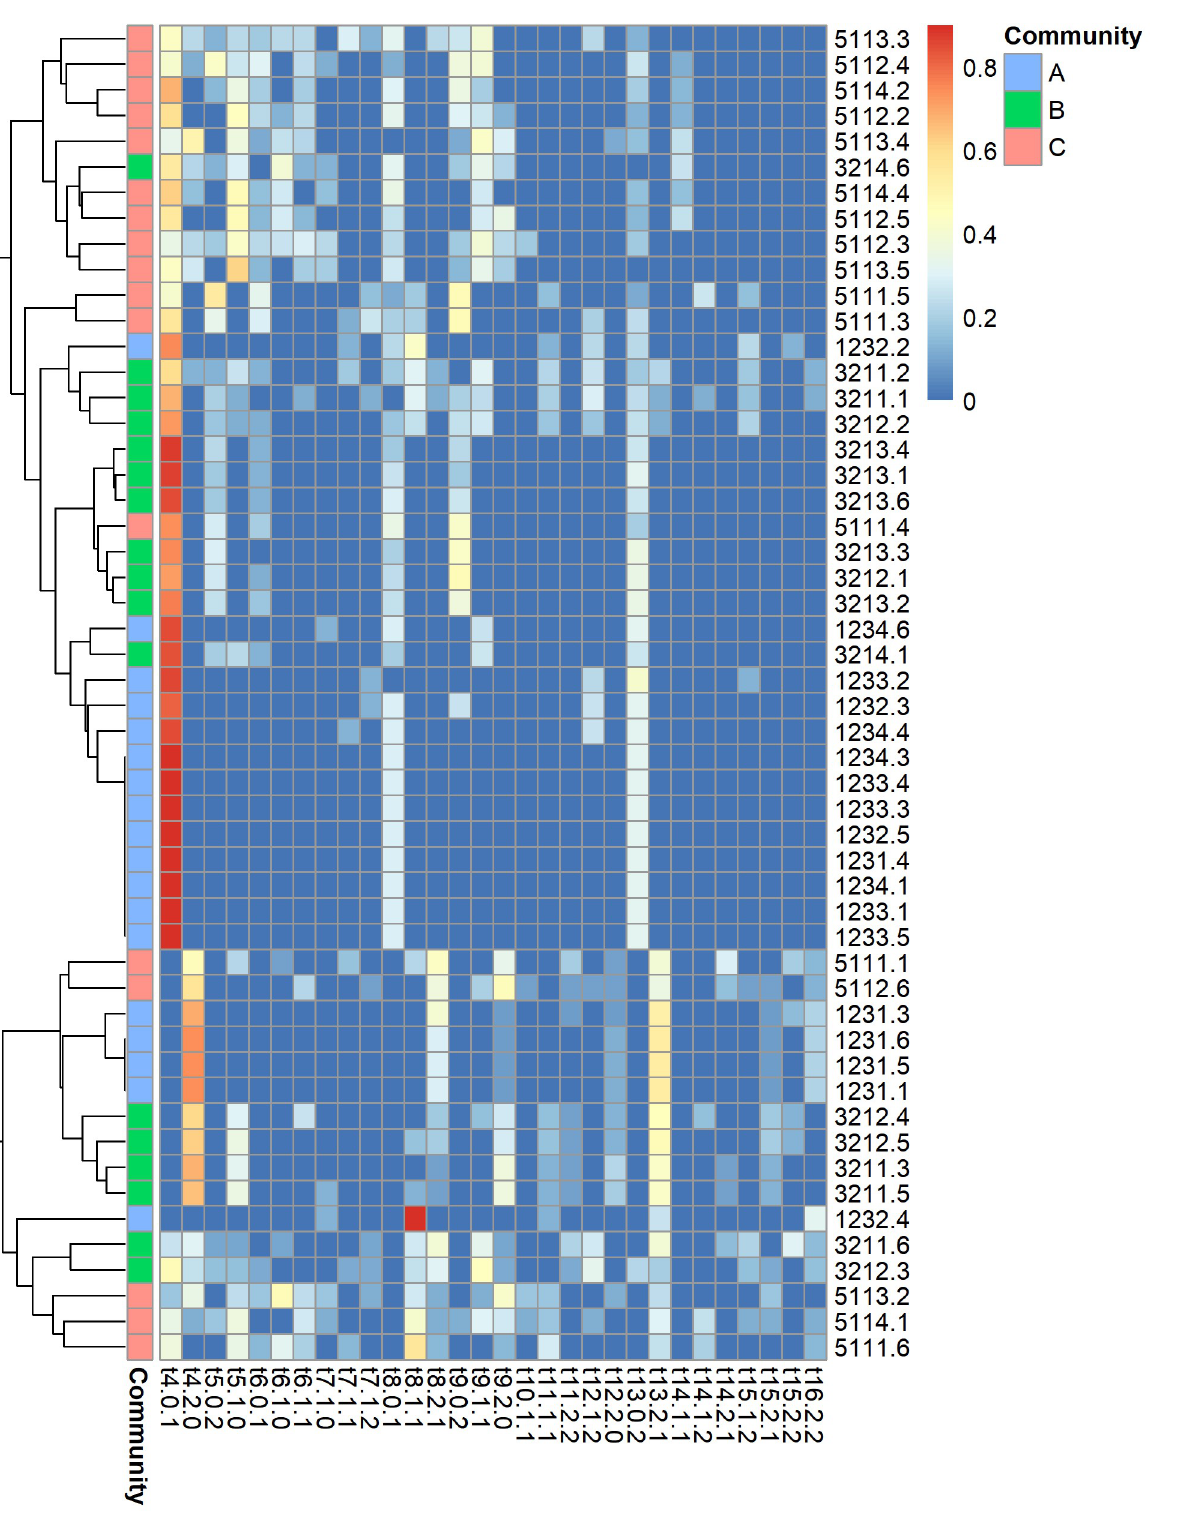
Fig 5. Heatmap square-root-transformed proportions of node participation in connected triads among nodes (right panel). Node participation allows for the comparison of the local structure of nodes among different networks. Labels indicate the triad (eg. t4 is triad 4), where the numbers following the triad identifier indicate the in- and out-degrees of the node within that